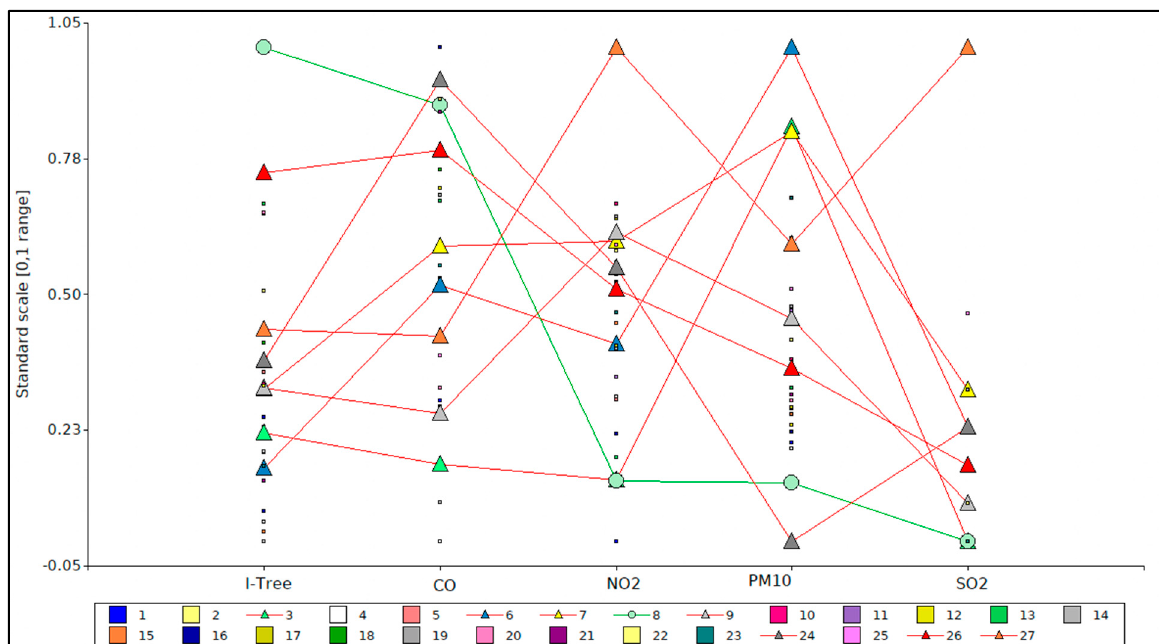
Figure 3. Results of pollutant (NO 2 , PM10, SO 2 and CO 2 ) and green infrastructure measurements (Itree-canopy) at the 27 sampling points in the National District. For sampling points location, see Figure 1.